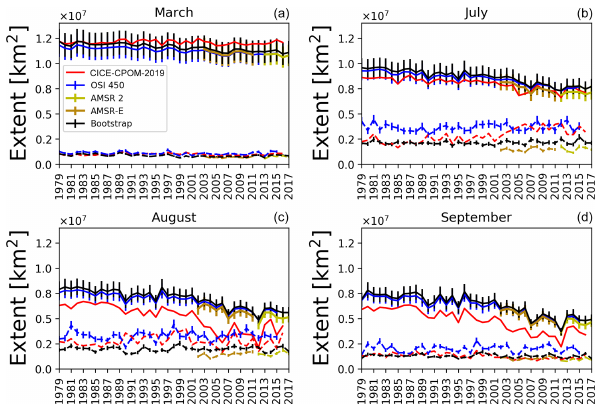
Figure 1. Arctic sea ice extent (solid lines) and marginal ice zone extent (dashed lines) from our CICE simulation CICE-CPOM-2019 and four remote sensing products for (a) March, (b) July, (c) Au- gust, and (d) September. Marginal ice zone extent is defined as the area where sea ice concentration is between 15% and 80%. Sea ice extent is the area of ice coverage above 15%. An error bar of 10% has been applied to the observational